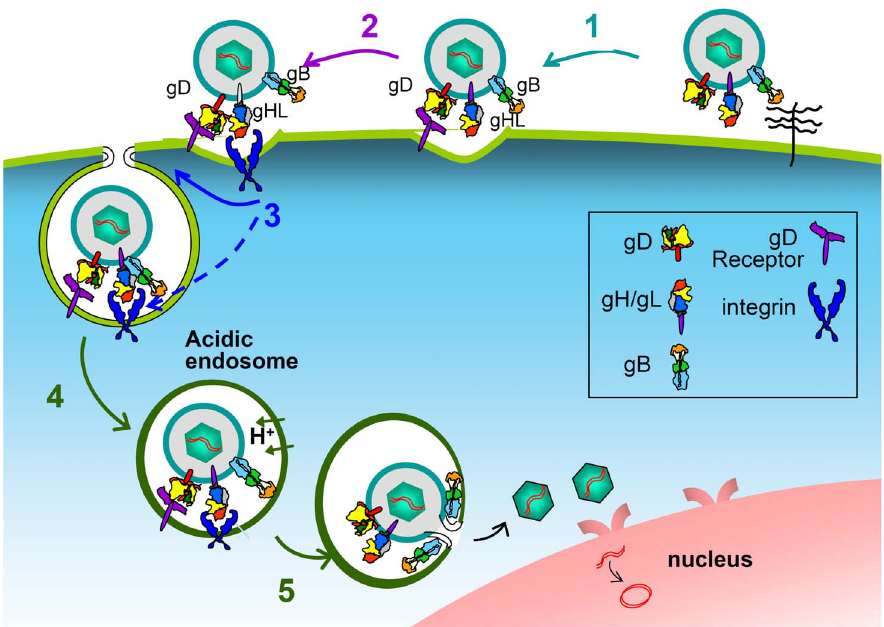
Figure 10. Schematic representation of the intervention of integrins in the process of HSV entry and in the cascade of activation of the fusion glycoproteins. Following HSV attachment to cells via heparan sulphate glycosaminoglycans (1), the interaction of gD with one of its receptors activates gD (2); the activation is propagated to gH/gL; the details of this interaction are still under investigation. Integrins intervene (3): they promote endocytosis, and, most likely, induce or contribute to conformational changes, hence to activation of gH/gL. The gH/gL activation is propagated to gB. Endosomal acidification (4). Fusion execution by gB (5). Color code of the glycoproteins as in [69]. gH/gL and gB are shown in the resolved post-fusion